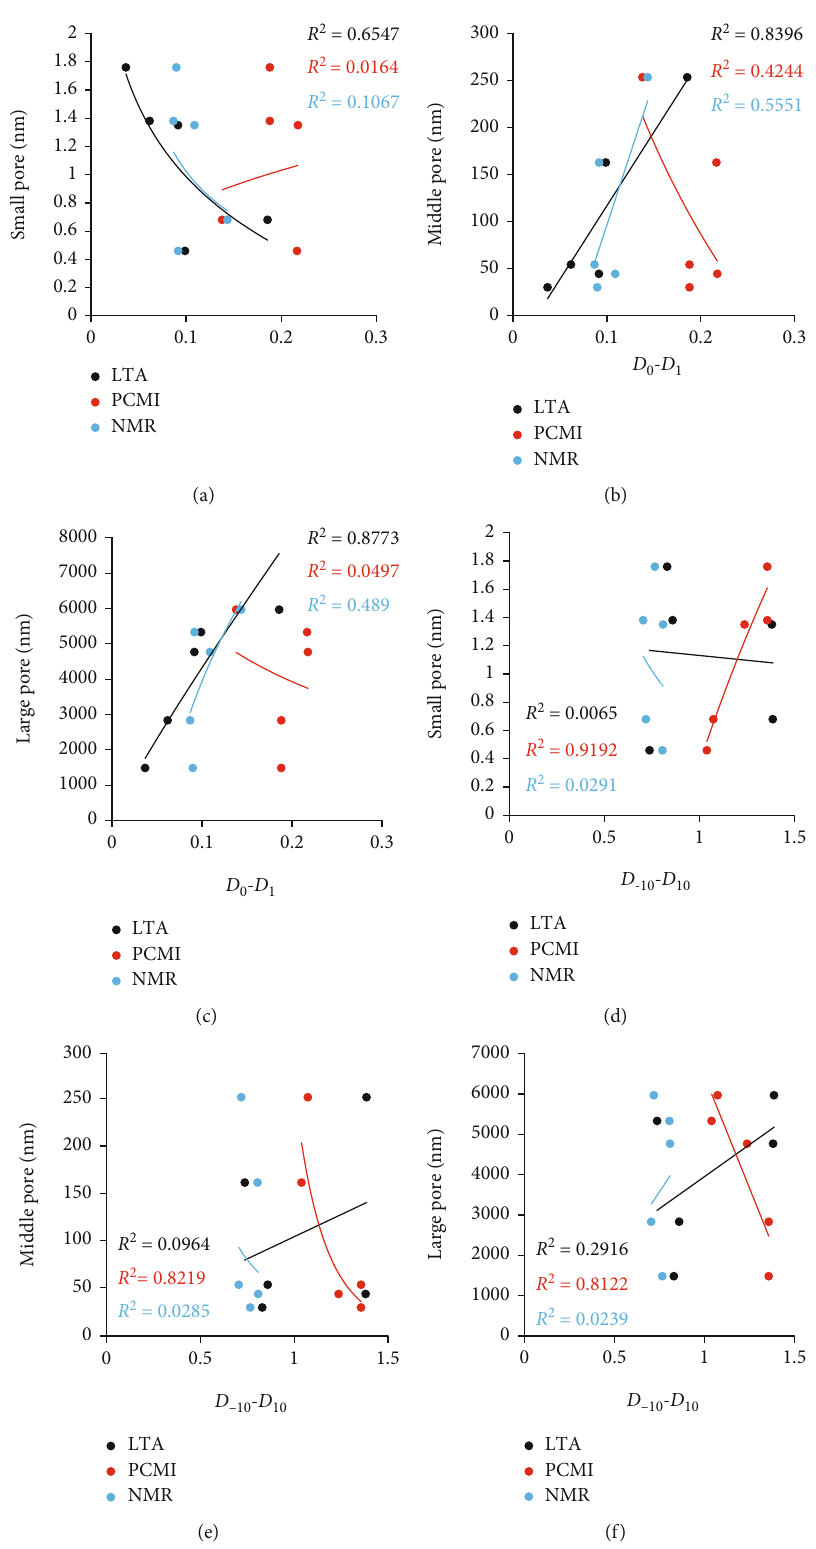
Figure 13: The impact on multifractal parameter from pore structure parameters: D pore radius; (c) average large pore radius, and D